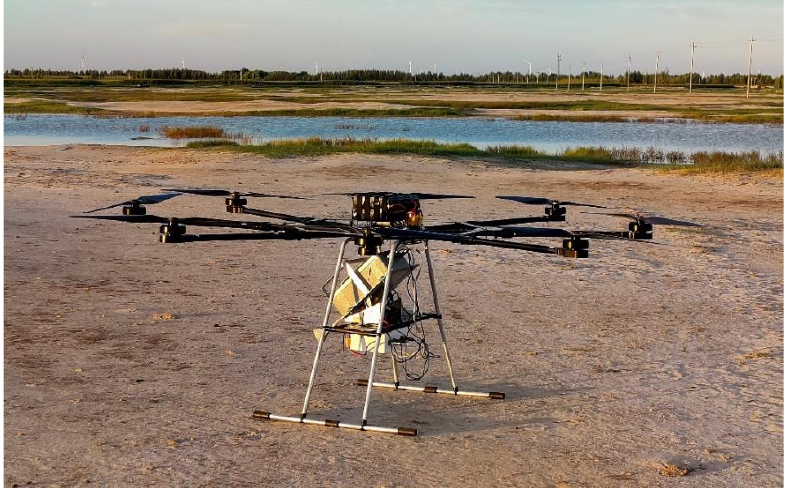
Figure 1. The drone-borne microwave radiometer and the UAV platform.